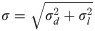
Statistically significant changes in population structure across stimulus conditions.A. Firing rate in the light condition plotted against firing rate in the dark for all N = 128 cells. Error bars are given by the standard error of the mean (SE) and are smaller than the plotted points. B. Pairwise correlation in the light plotted against pairwise correlation in the dark, for all 128 ⋅ 127/2 pairs of cells. Error Bars are not shown (but see panel D). Inset is the probability density function (PDF), on a log scale, of correlation coefficients. C. Measured P(K) in the two light conditions. K is the number of active cells in a state. Error bars are given by the SE. D. The PDF of z-scores of changes in correlation coefficients. The change in correlation coefficient is normalized by the error (σ=σd2+σl2). These error bars are standard deviations over bootstrap resamples of the data, estimated per cell pair. Data compares the light and dark adapted conditions (thick black line), the control compares a random half of the dark dataset to the other half (gray), and a numerical gaussian is plotted in red for comparison.